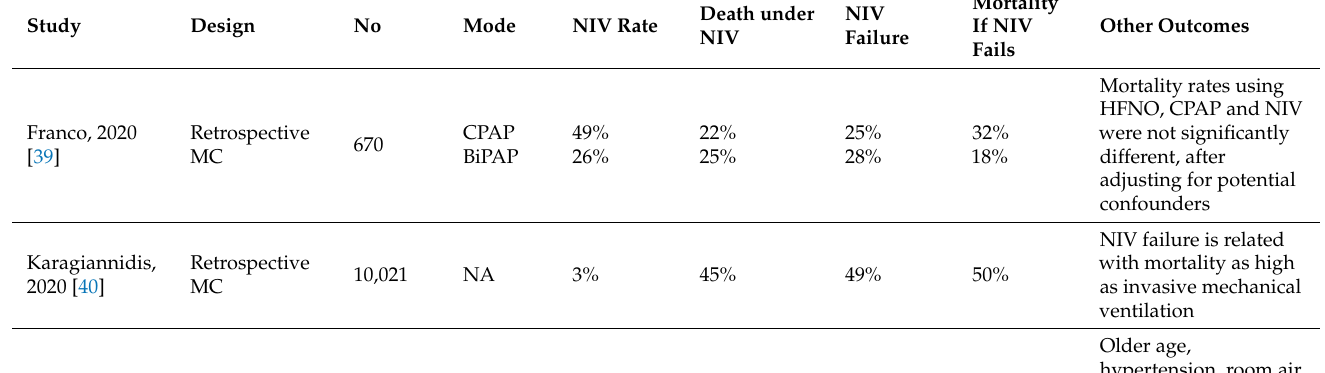
Table 2. Evidence for the use of NIV (CPAP or BiPAP) in patients with COVID-19-associated hypoxemic respiratory failure.